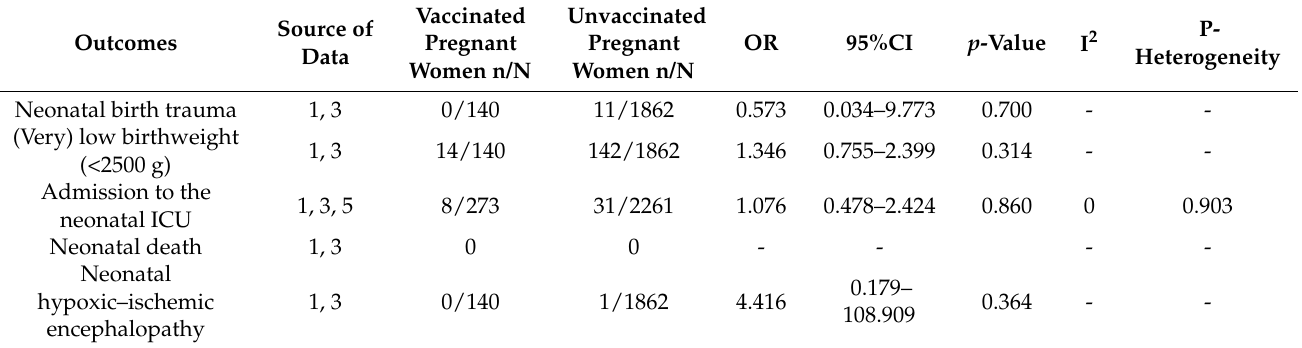
Table 9. Adverse neonatal outcomes among pregnant women with and without COVID-19